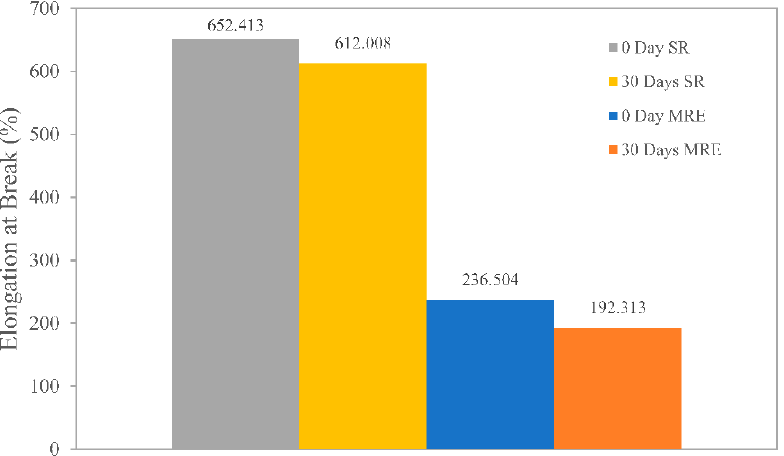
Figure 6. Elongation at break of SR and MRE under natural weathering conditions.